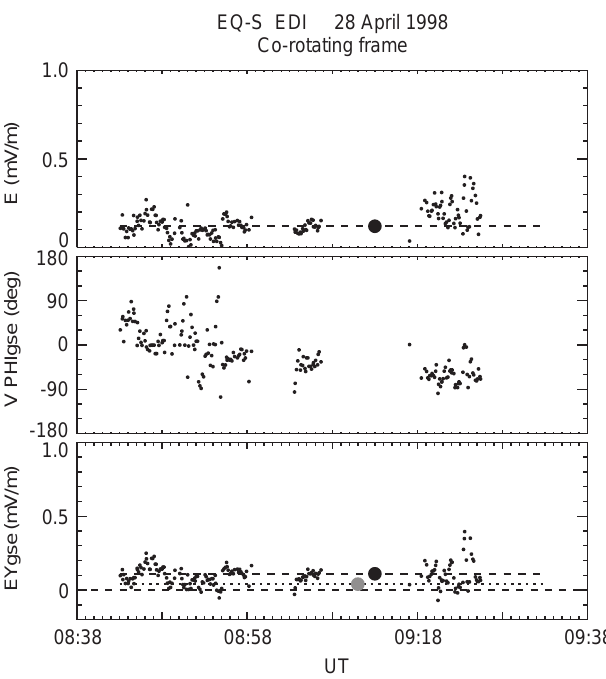
Fig. 5. EDI triangulation results for April 28, 1998, in the frame co- rotating with the Earth. The electric-field magnitude ( top ), drift direction in the X - Y plane ( center ), and the Y component of GSE GSE the electric field are shown by dots at approximately 8-s sampling. The dashed black line ( top and bottom ) represents the mapped Weimer model for a 40-min solar wind average. The dotted line ( bottom ) are Rowland and Wygant (1998) CRRES results, parameterized by K . p Missing data (08:59–09:02 and 09:07–09:16), are periods when EDI triangulation telemetry are unavailable due to testing of other